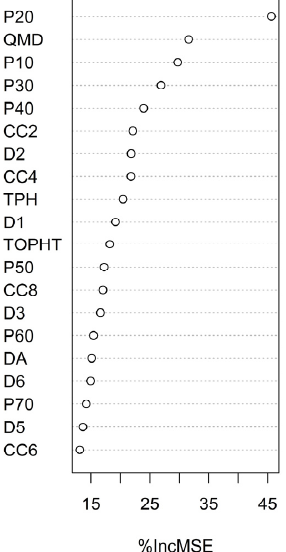
Figure 4. Variable importance plot of LiDAR-derived variables generated from the random forests model. %IncMSE = Percent increase in mean-squared error when the variable is removed from the model. Forests 2016 , 7 , 311